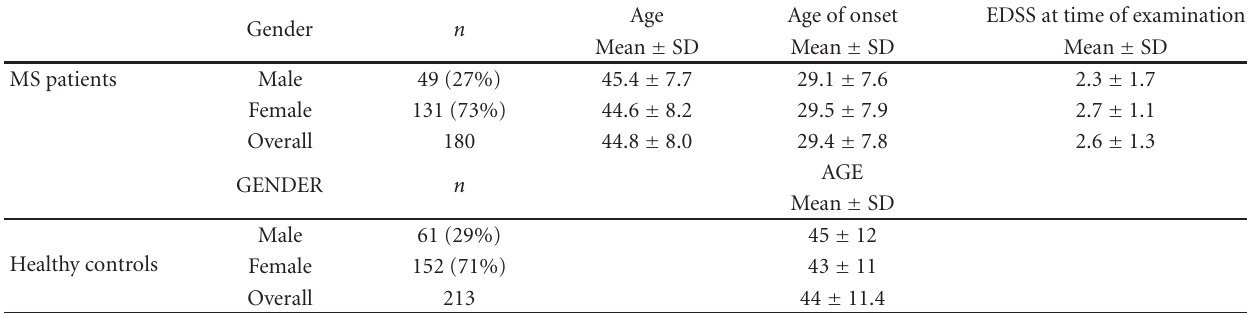
Table 1: Demographic and disease-related data of our